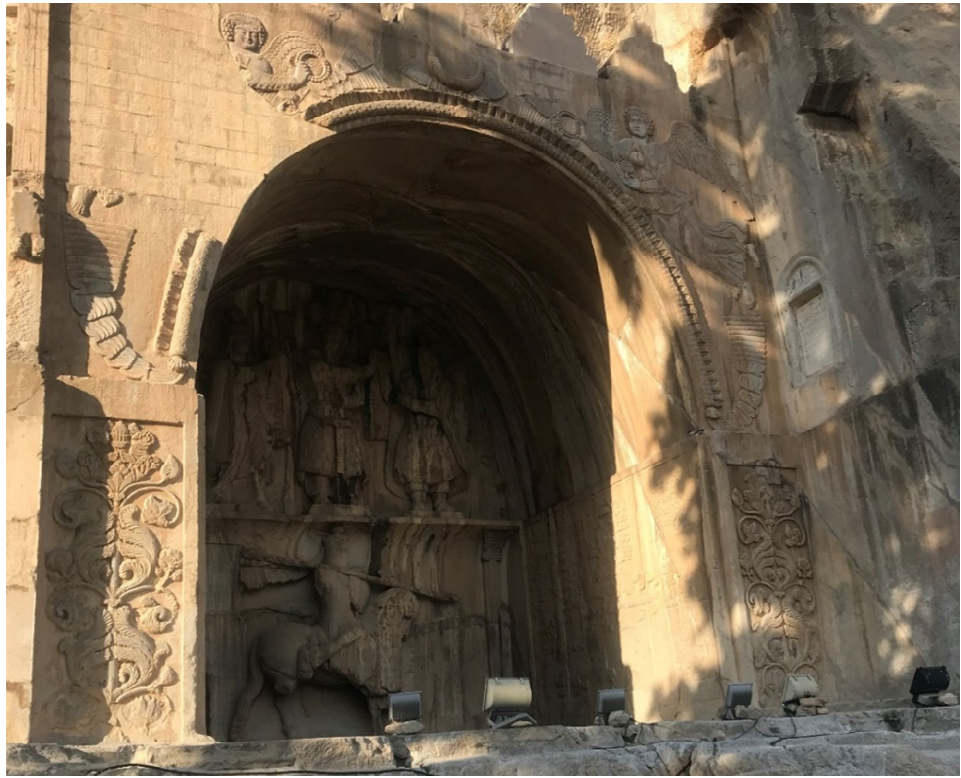
Figure 1. Taq ‐ e Bustan, The Great Grotto. Source: authors. Figure 1. Taq-e Bustan, The Great Grotto. Source: